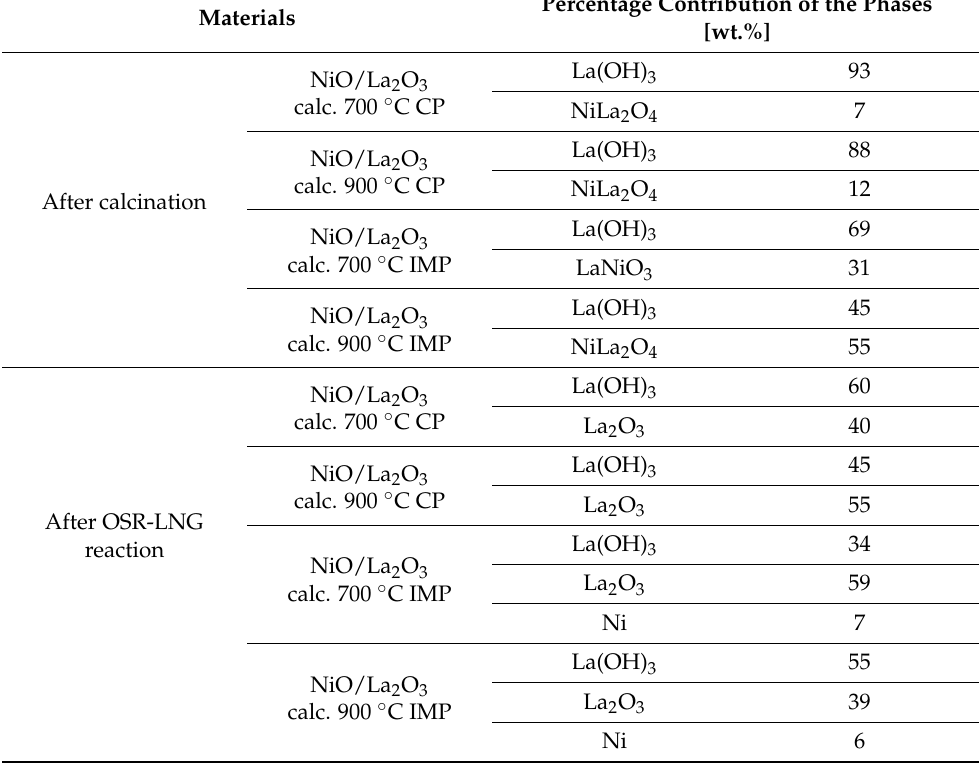
Table 6. The percentage contribution of crystallographic phases determined for the investigated catalysts after calcination process and the spent catalysts in the OSR-LNG reaction calculated based on the XRD